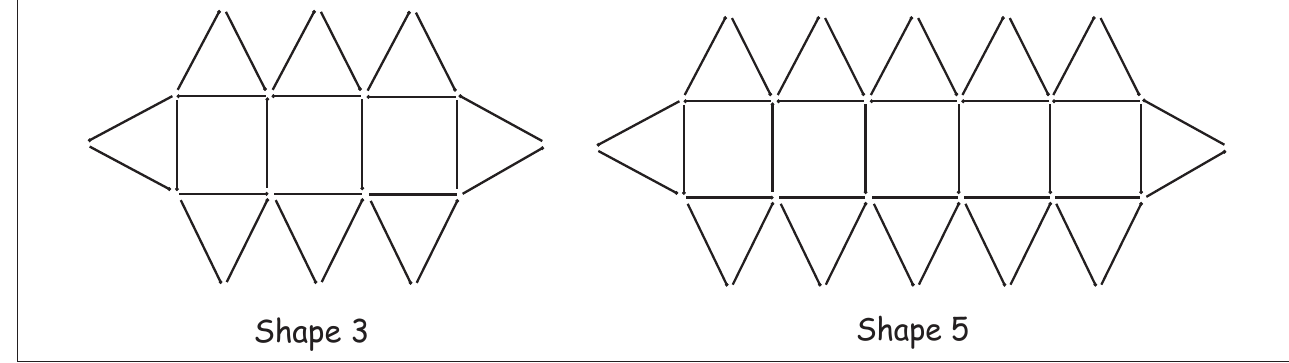
FIGURE 6: Pictorial pattern presented to